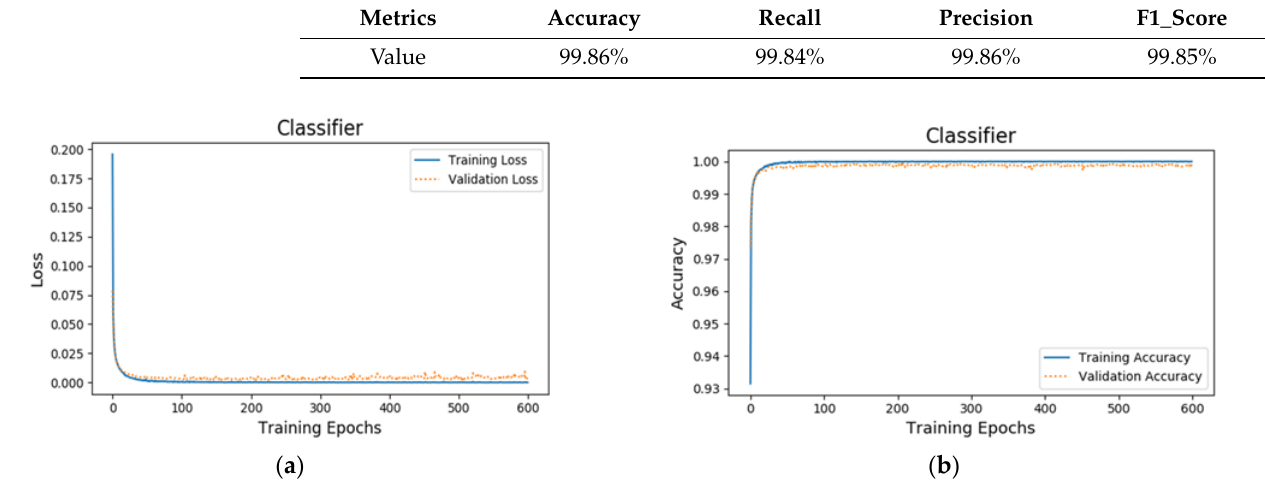
Figure 10. ( a ) The training and validation’s loss, and ( b ) the accuracy of the classifier over training epochs.